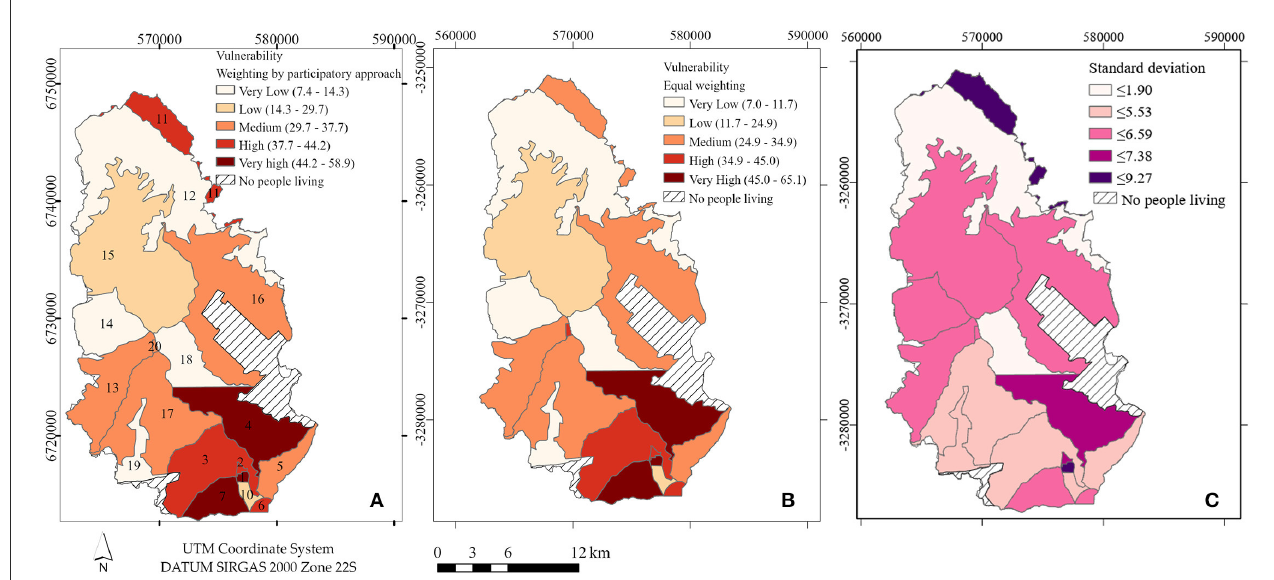
FIGURE8 Final vulnerability maps: (A) mean vulnerability obtained by averaging the results of each individual map; (B) considering equal weights; and (C) standard deviation of the vulnerability maps obtained by considering each stakeholder weighting